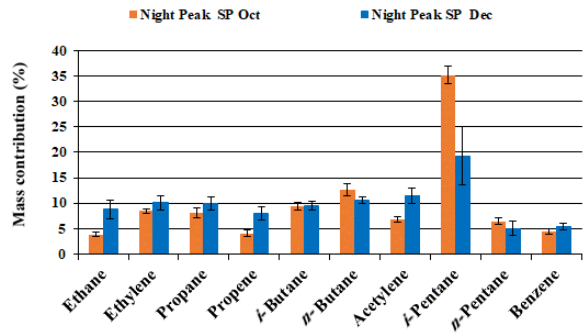
Figure 11. The percent mass contribution of the measured NMHCs during the nighttime enhancement period (18:00–05:00LT) for the SP in October (orange) and the SP in December